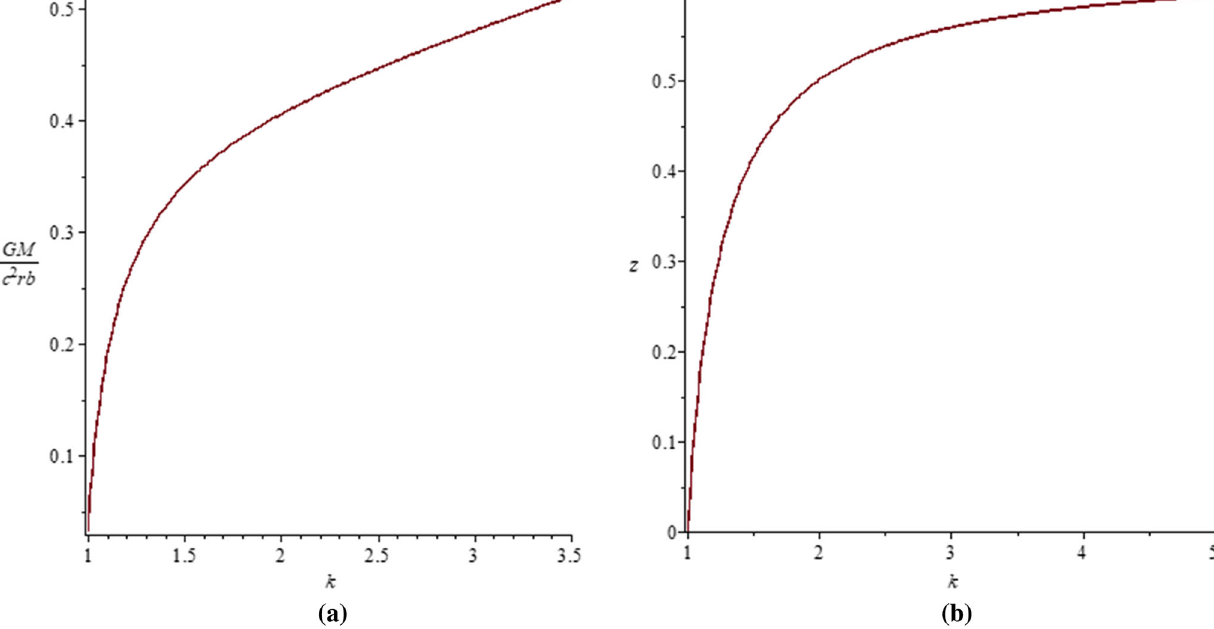
Fig. 5 Thedimensionlessquantitywhichisrelatedwiththegravitationalmass( a )andthegravitationalsurfaceredshift( b )versusthedimensionless parameter k for α =